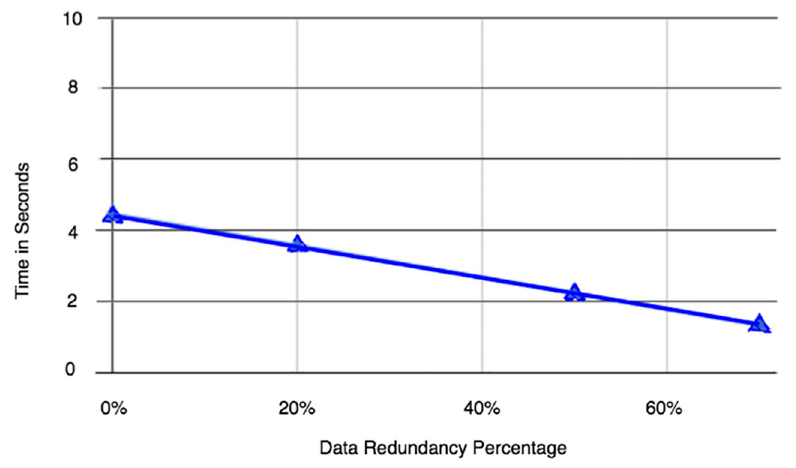
Fig 13. The required time of encryption vs. data redundancy percentage.